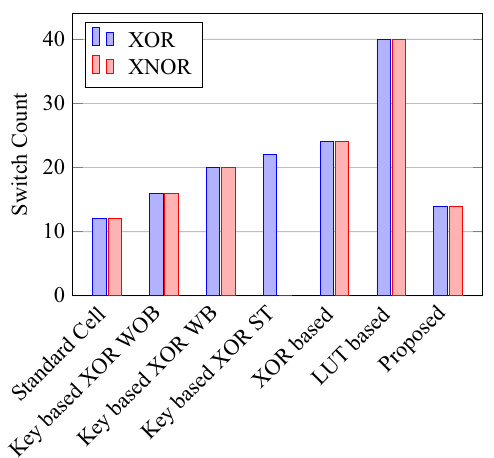
Figure 34. Switch count for XOR and XNOR.